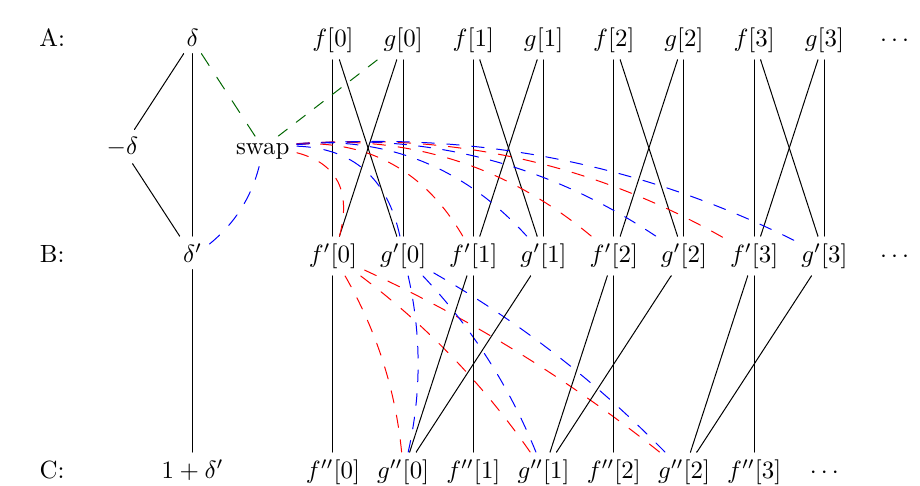
Figure 3.3: Data flow in an x -adic division step decomposed as a conditional swap (A to B) followed by an elimination (B to C). The swap bit is set if δ > 0 and g [0] 6 = 0. The g outputs are f 0 [0] g 0 [1] − g 0 [0] f 0 [1], f 0 [0] g 0 [2] − g 0 [0] f 0 [2], f 0 [0] g 0 [3] − g 0 [0] f 0 [3], etc. Color scheme: consider, e.g., linear combination cg − df of power series f, g where c = f [0] and d = g [0]; inputs f, g affect j th output coefficient cg [ j ] − df [ j ] via f [ j ] , g [ j ] (black), and via choice of c, d (red+blue). Green operations are special, creating the swap